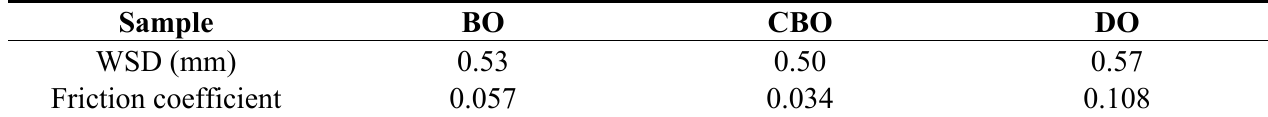
Table 4. WSD and friction coefficient values of the BO, CBO and DO tested under 196 N.